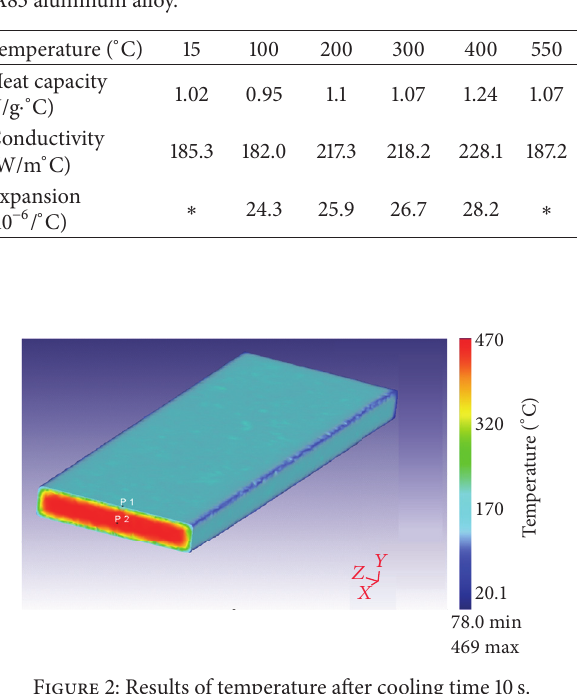
Figure 2: Results of temperature after cooling time